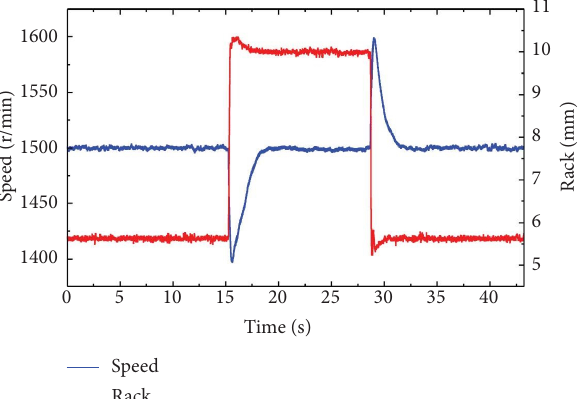
Figure 19: Experimental results of load sudden change for the traditional PID